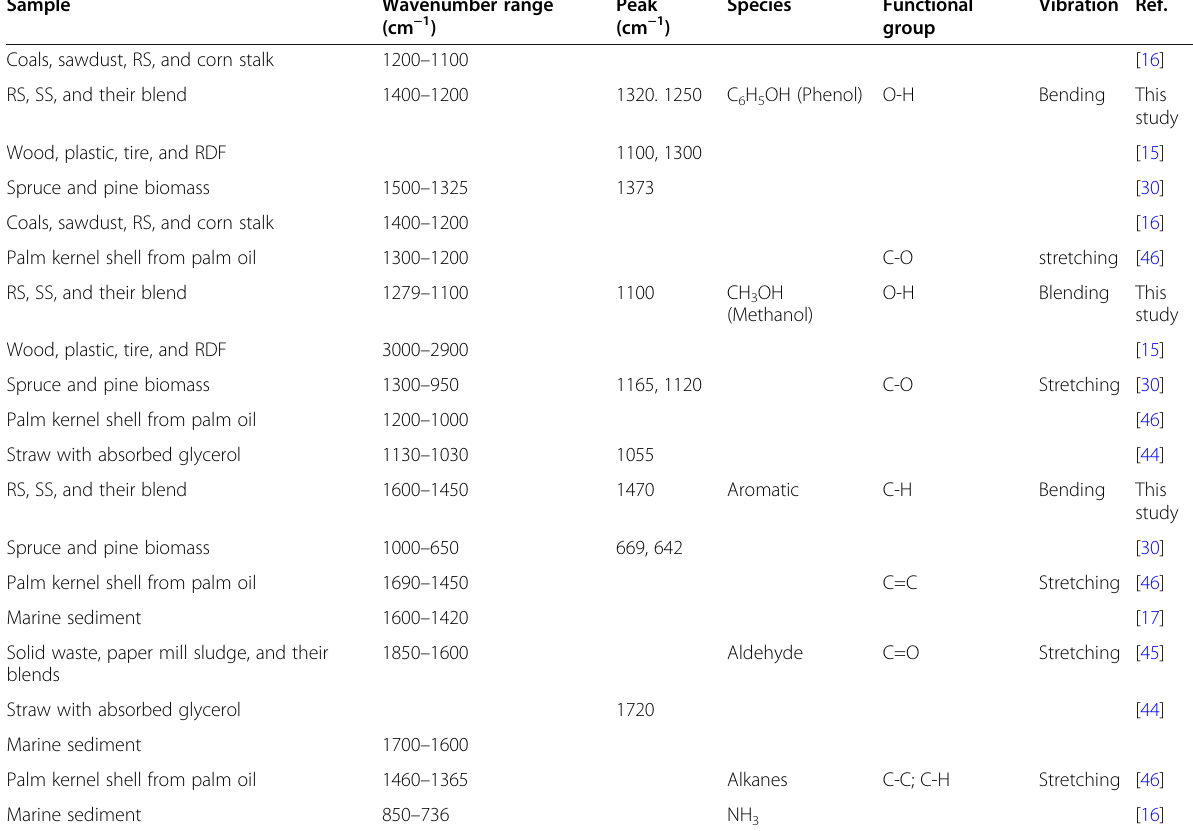
Table 4 Gaseous species based on wavenumbers (cm − 1 ) and functional groups for pyrolysis studies (Continued)